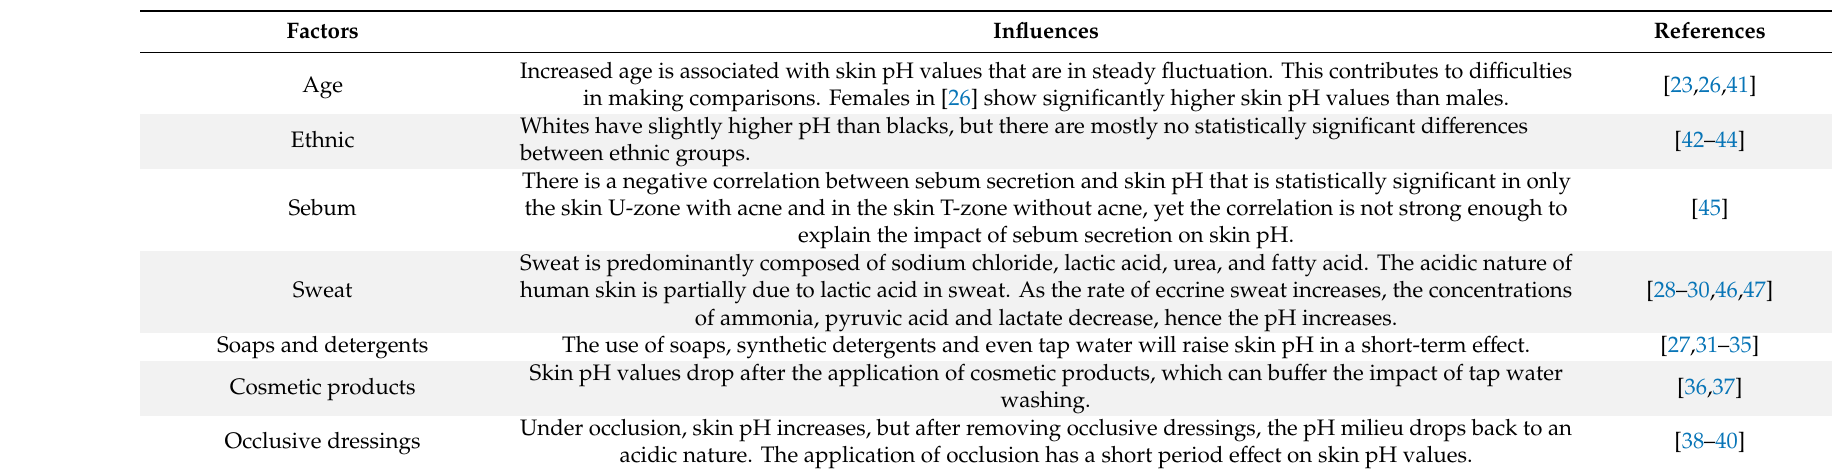
Table 2. Factors that have influences on skin